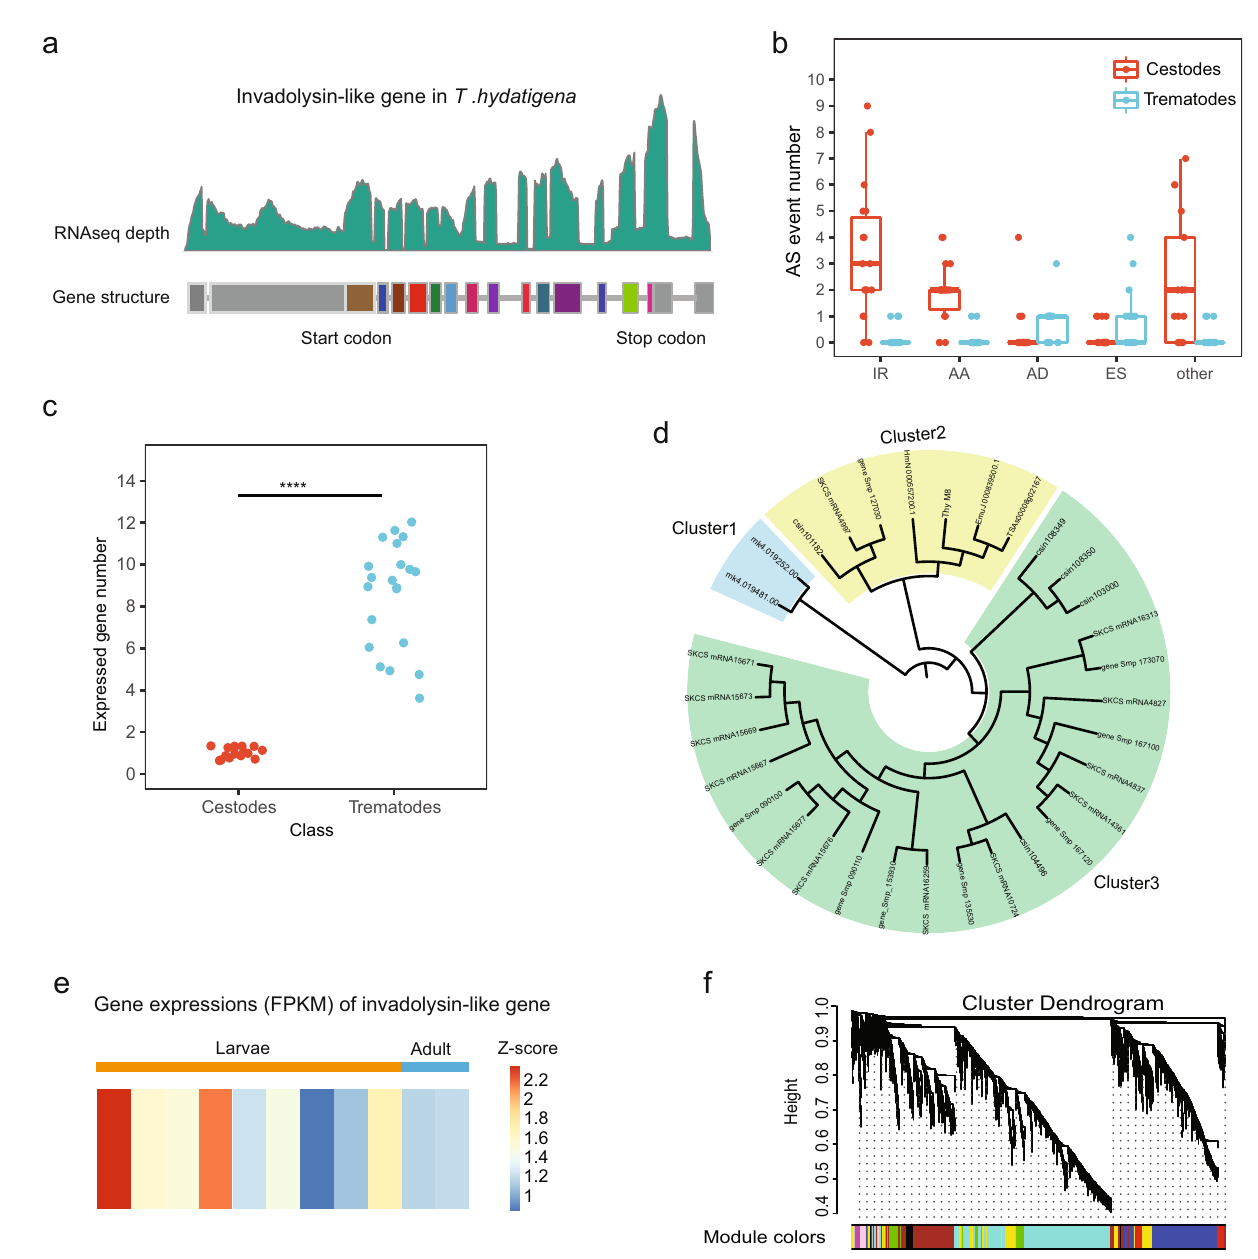
Fig. 4 Invadolysin-like genes in T. hydatigena and other fl atworms. a The gene structure of the gene encoding ‘ invadolysin ’ (M08 peptidase) in T. hydatigena . The gene structure was manually curated based on RNA-seq data and gene model prediction. Splice junctions were manually con fi rmed using the alterative splicing information identi fi ed from the RNA-seq data. The gray regions indicate untranslated regions (UTRs). b Alternative splicing events detected in samples of cestodes ( T. hydatigena , T. saginata , T. asiatica , and T. solium ) are signi fi cantly higher than the samples of trematodes ( S. mansoni , S. japonicum, and C. sinensis ). Available samples at different life stages for each species were used for alternative splicing event identi fi cation (see ‘ Methods ’ ). Few alternative splicing isoforms of M08 peptidases were detected from trematodes. c The expressed (sequencing depth >1) gene members of M08 peptidase family at different developmental stages for each involved species in the cestodes ( n = 1 for T. hydatigena , T. saginata , T. asiatica , and T. solium ) are less than those in the trematodes ( S. mansoni, S. japonicum , and C. sinensis ). d Phylogenetic tree for the genes encoding ‘ invadolysin ’ in platyhelminths. Cluster 1 consists of invadolysin-like genes identi fi ed in the genome of S. mediterranea ; cluster 2 consists of invadolysin-like genes identi fi ed from the genomes of cestodes and trematodes; cluster 3 only consists of invadolysin-like genes identi fi ed from the trematode genomes. e Expression levels (FPKM) of the invadolysin-like gene in T. hydatigena . f The invadolysin-like gene in T. hydatigena was clustered into a module (turquoise) in WGCNA analysis. This module showed a higher eigengene expression level at days 30 and 60 post infection in the intermediate host (sheep). The whiskers of boxplot indicate 1.5 × interquartile range. **** p < 0.0001 using the two-sided Wilcoxon rank sum test (con fi dence level =